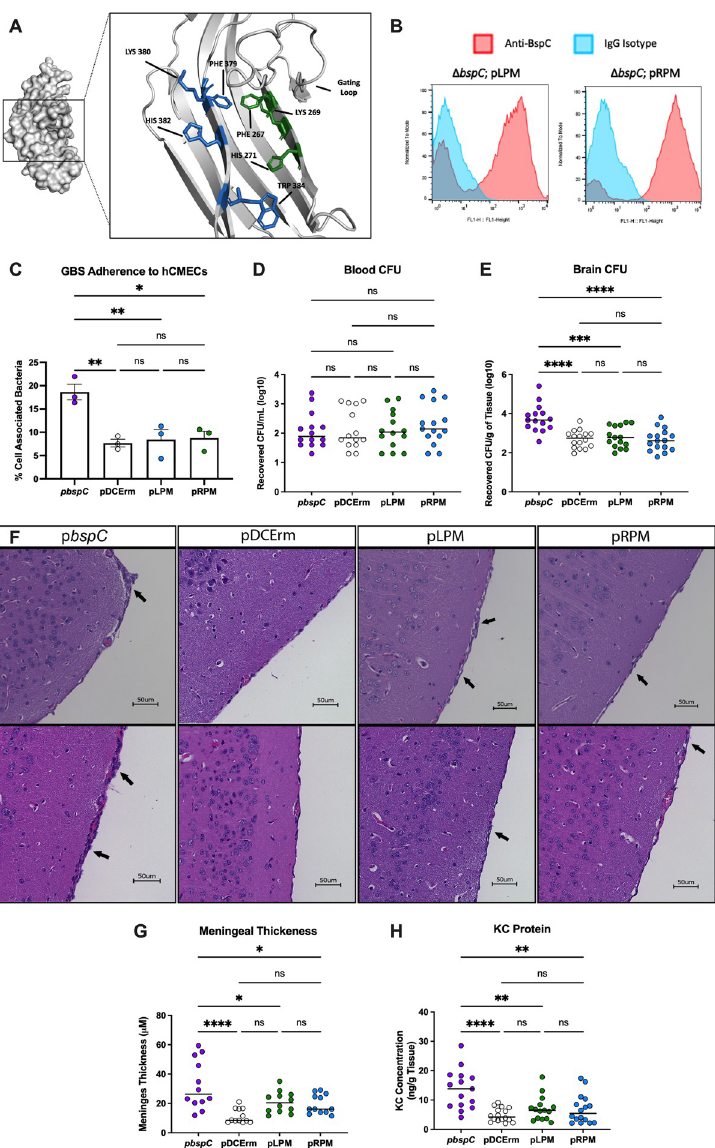
Fig 5. The V-domain pocket contributes to BspC Function (A) Zoomed in view of the V-domain pocket with residues targeted for mutagenesis. Residues shown in blue were targeted to construct LPM, and residues shown in green were targeted to construct RPM. Visualization done using PyMOL. (B) COH1 Δ bspC GBS containing pDCErm bspC (p bspC ), pDCErm bspC LPM (pLPM), pDCErm bspC RPM (pRPM) or the empty vector (pDCErm) were stained with an anti-BspC antibody or isotype control without permeabilization. Surface bound antibody was measured via flow cytometry. (C) The same strains used in (B) were used to infect a monolayer of hCMECs. CFU were plated to assess adherence after 30 minutes of incubation. (D-H) Mice were infected with ~4x10 8 CFU of the same strains used in (B) and then sacrificed after 48 hours. (D) Half of each mouse brain was homogenized and plated on THA-Erm to determine bacterial burden. (E) Blood from each mouse was also plated on THA-Erm to determine bacterial burden. For (D) and (E) , data is pooled from two independent experiments, each dot represents an individual mouse, and lines indicate statistical means. (F) H&E stains showing the leptomeninges from two individual mice per group, one from each independent experiment. Arrows indicate areas of leukocyte infiltration and meningeal thickening. (G) ImageJ was used to analyze meningeal thickness from 5 mice per group from the two independent experiments. Two images were taken of each brain, and three points per image were measured with each dot representing an individual point. (H) KC protein concentration was quantified via ELISA from brain homogenates shown in D. Data for H is pooled from two independent experiments, where each dot represents an individual mouse brain, and lines indicate statistical means. Statistical analysis: (C, D, E, G, and H) One-way ANOVA with Tukey’s multiple comparisons. � , P < 0.05; �� , P < 0.005; ��� , P < 0.0005; ���� , P <